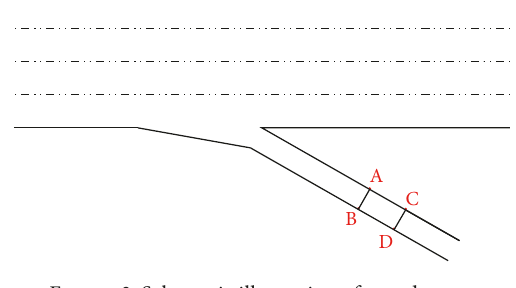
Figure 3: Schematic illustration of a study area.